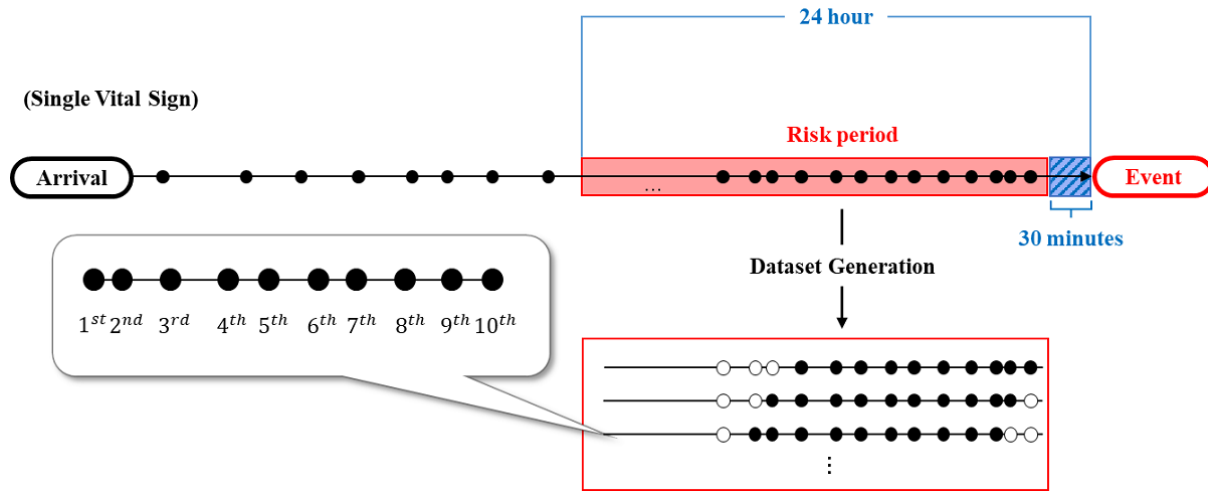
Figure 2. Sequential dataset generation for a single vital sign of one patient. The risk period was defined as a 24-hour interval prior to the event. The 10 consecutive vital signs were grouped as a data set for prediction. Each point represents a single vital sign measurement. This process was applied to other vital signs in the same